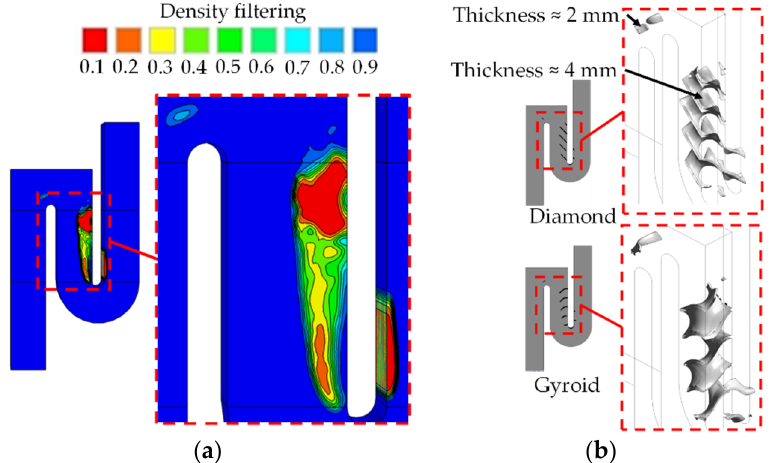
Figure 8. ( a ) 3D optimal solution including intermediate results; ( b ) topology optimization model infilled with lattice structures.